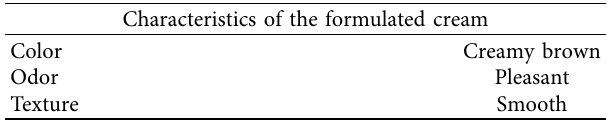
Table 2: Physicochemical characteristics of the neem oil. Table 3: Organoleptic characteristics of formulated neem seed oil cream.